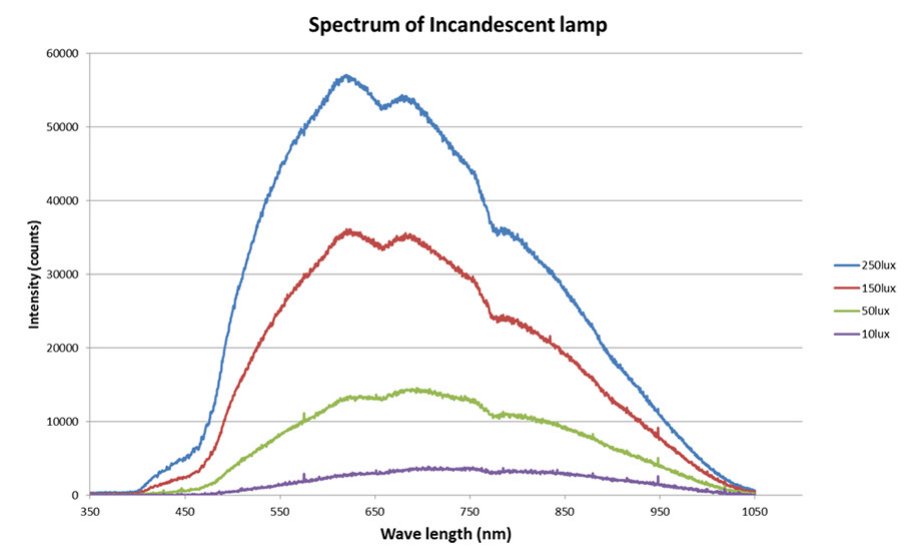
Figure 12. Spectrum of an incandescent lamp under various kinds of illumination (3000 K). Table 2. Relationships between illuminance and the portion of the NIR band spectral